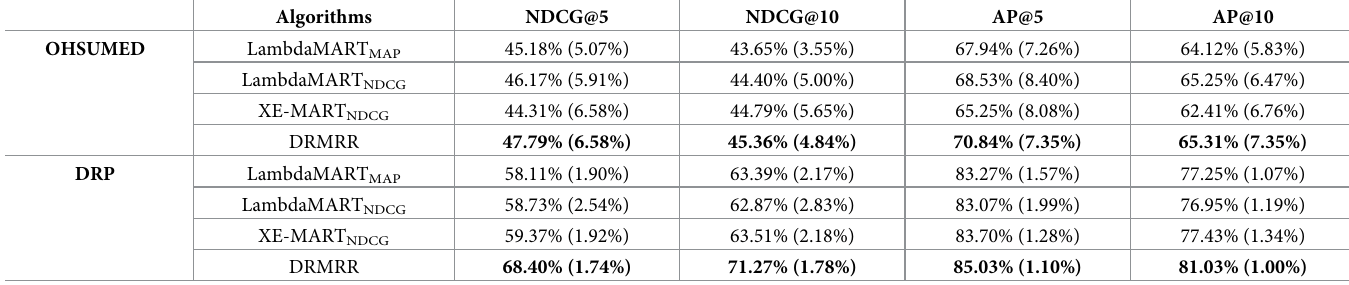
Table 1. Performance comparison of ranking